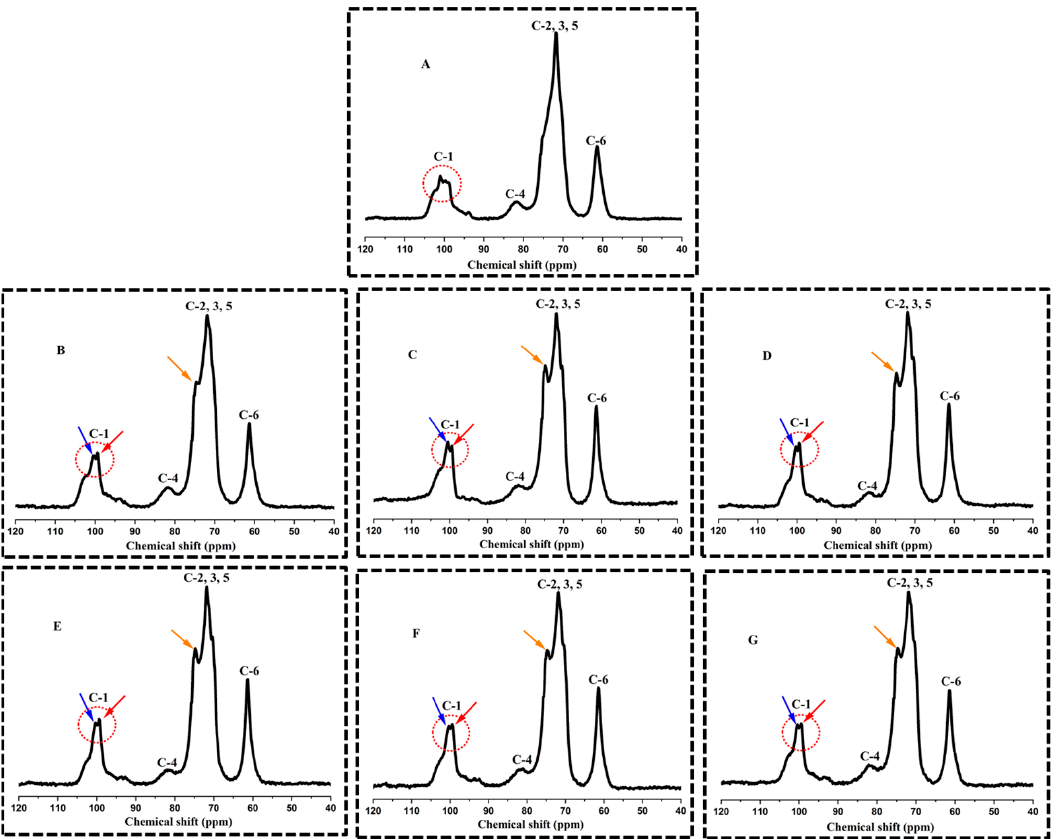
Figure 4. Solid state 13 C nuclear magnetic resonance spectroscopy characteristics of native starch (NS) and debranched starches (PDA) at different treatment times combined with autoclaved. ( A ) indicated NS; ( B – G ) indicate PDA 0 h, PDA 5 h, PDA 10 h, PDA 15 h, PDA 20 h, and PDA 25 h, respectively.